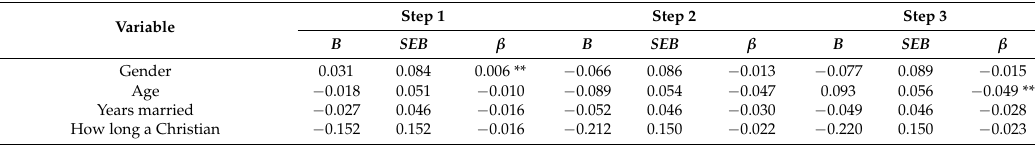
Table 4. A summary of the hierarchical regression analysis for variables predicting a negative interaction ( N =